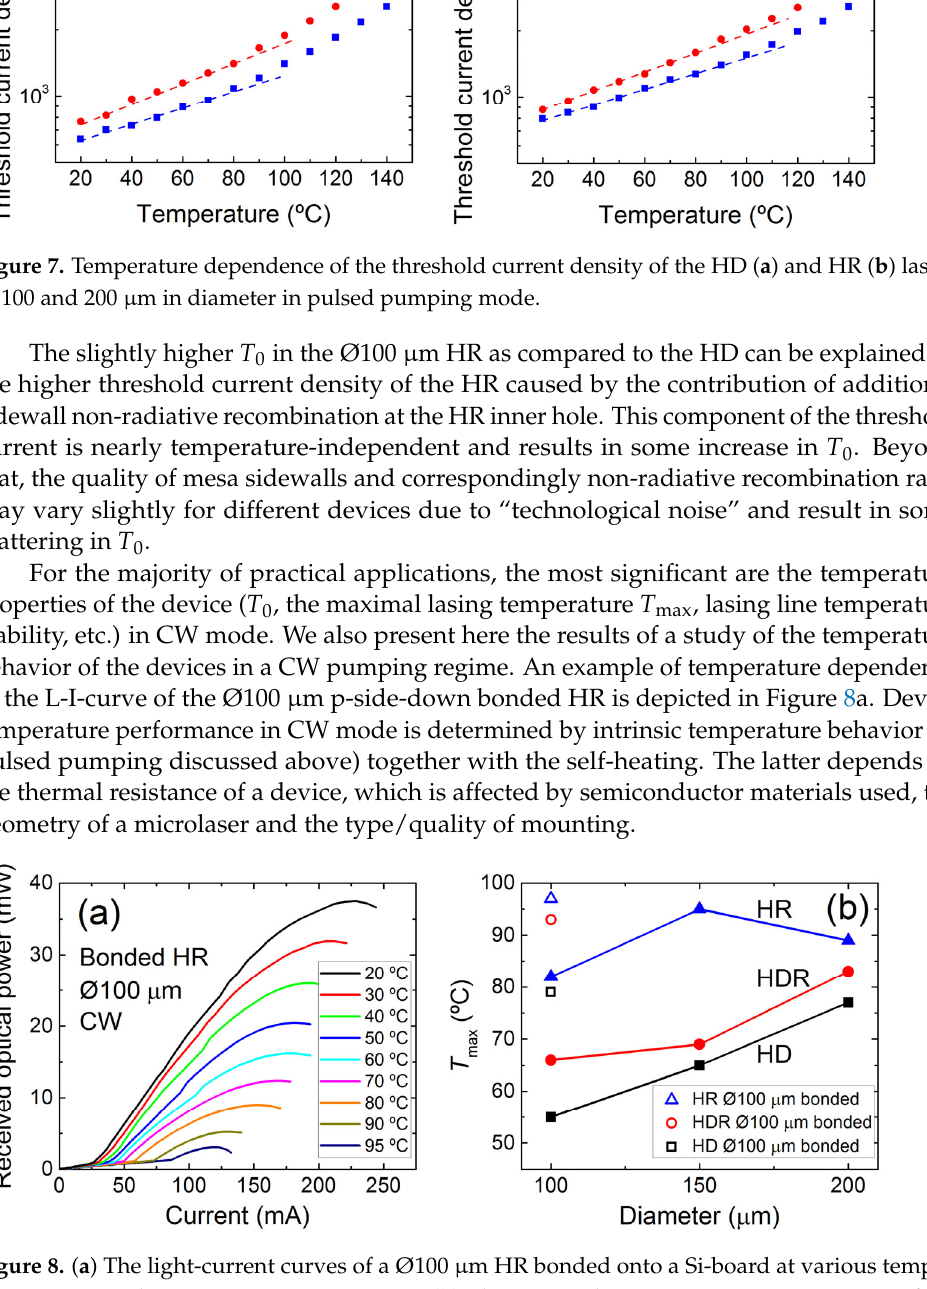
Table 1. The characteristic temperature of the threshold current density for CW mode pumping T 0CW ( К ) of HDs, HDRs and HRs of various diameters and mounting types.